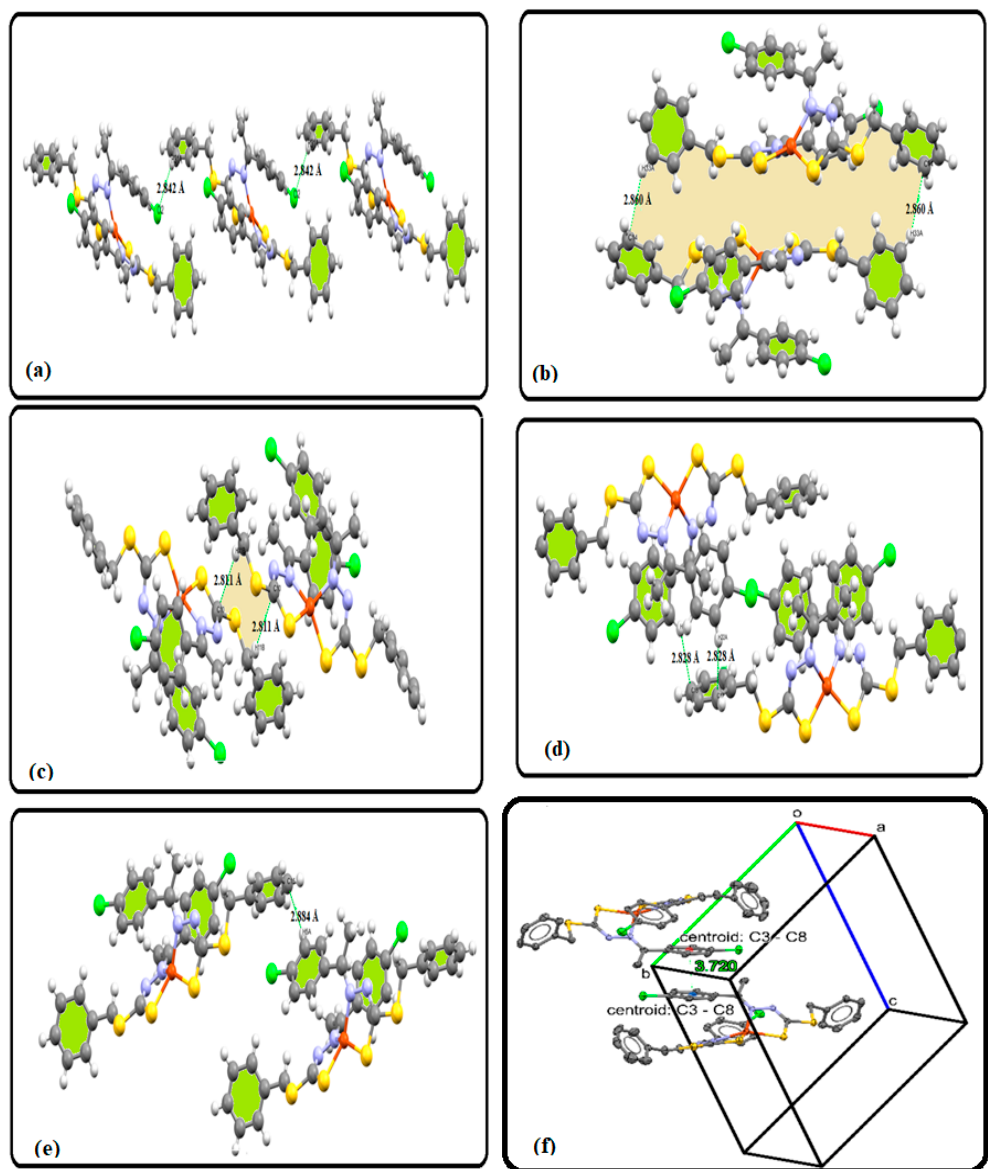
Figure 6. Total interaction in the lattice of cis -Cu(II) complex: One-dimensional supramolecular chain formation ( a ), R(38) motif ( b ), R(8) motif ( c ), classical CH ⸱⸱⸱ π bond short contacts ( d ), classical C ph -H ⸱⸱⸱ π Ph short contacts ( e ), and antiparallel π ⸱⸱⸱ π stack interaction ( f ).